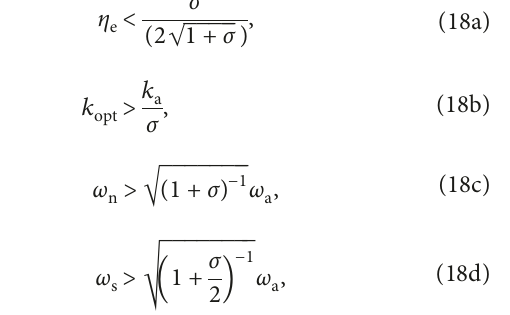
Figure 5: A lead compensator C line)-angle (solid) plot. The maximum loss angle δ max (and η max ) varies according to α , where α min Equation